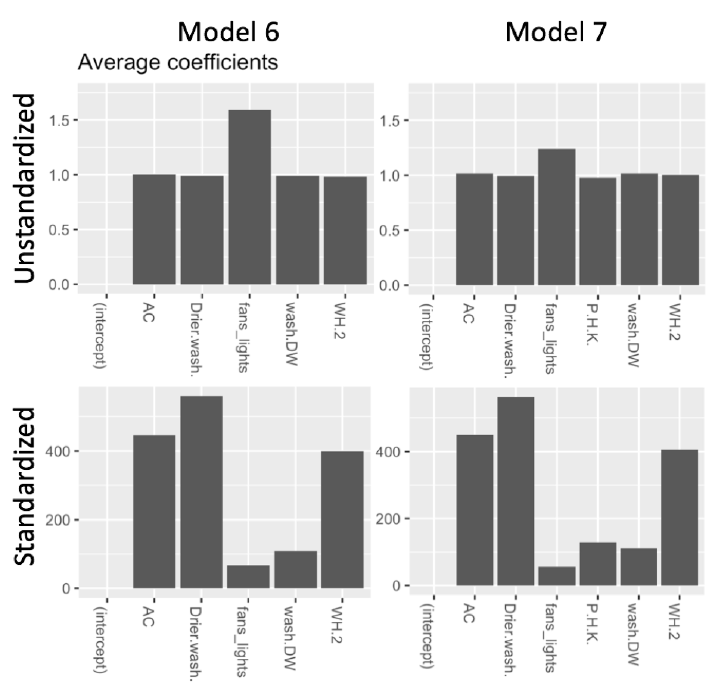
Figure 5. The coefficients for model 6 and model 7 both standardized and